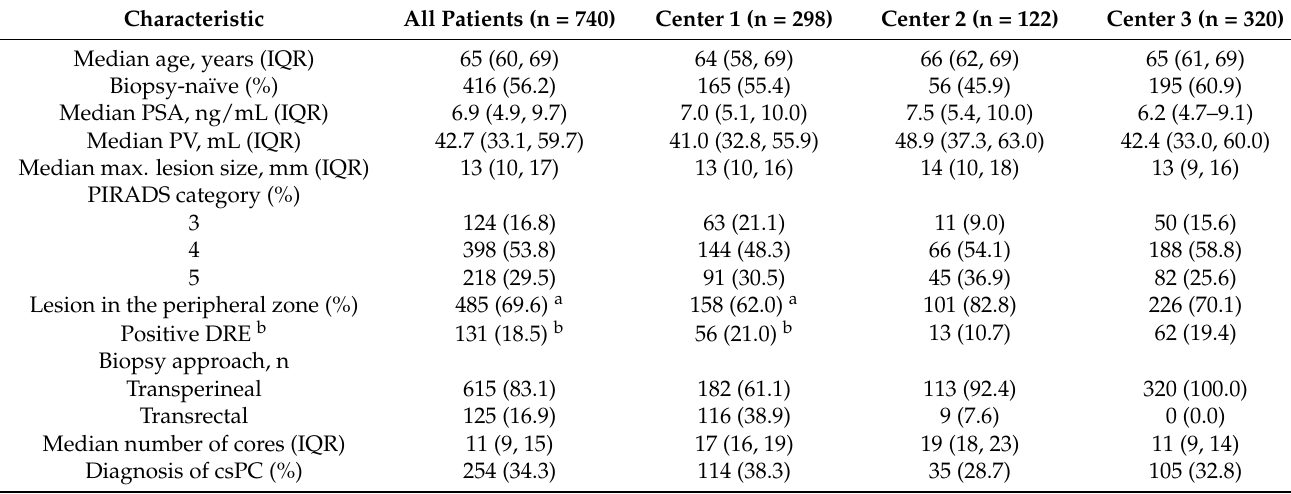
Table 1. Characteristics of